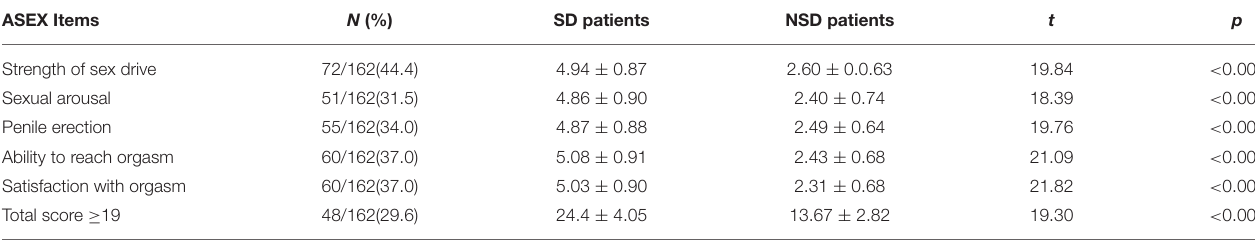
TABLE 1 | Frequency of sexual dysfunction in each domain of ASEX.